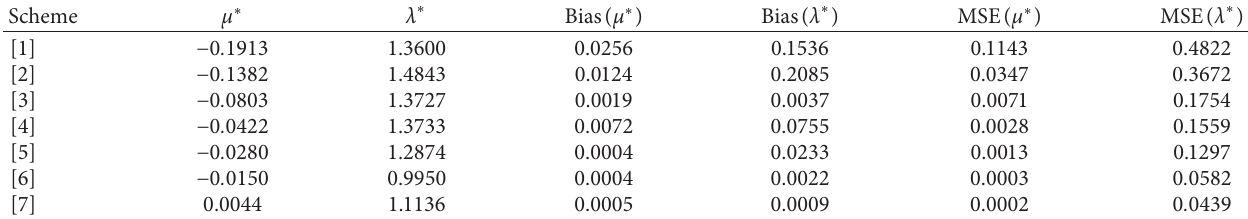
Table 4: ABLUEs μ ∗ , λ ∗ , biases, and MSEs for μ and λ from APE distribution when α � 2 .